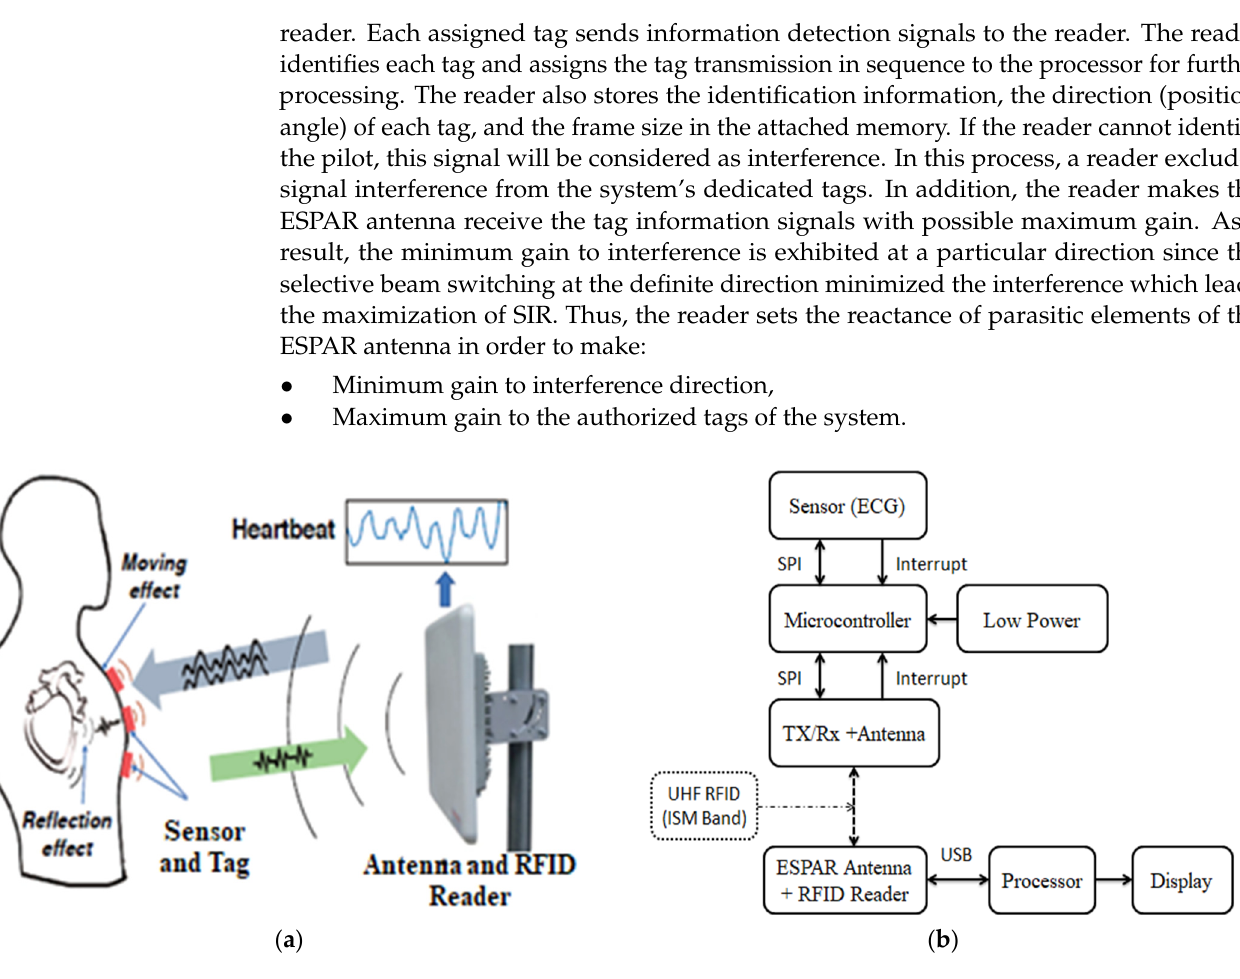
Figure 1. ( a ) Illustration of the working principle of ECG; ( b ) UHF RFID communication system for ECG monitoring.